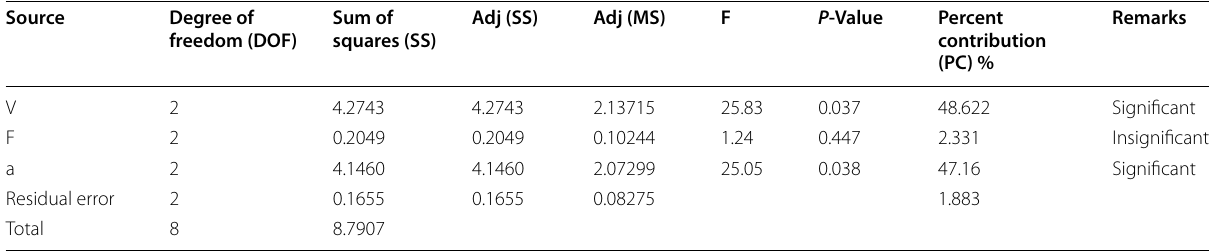
Table 12 ANOVA optimization for tool wear